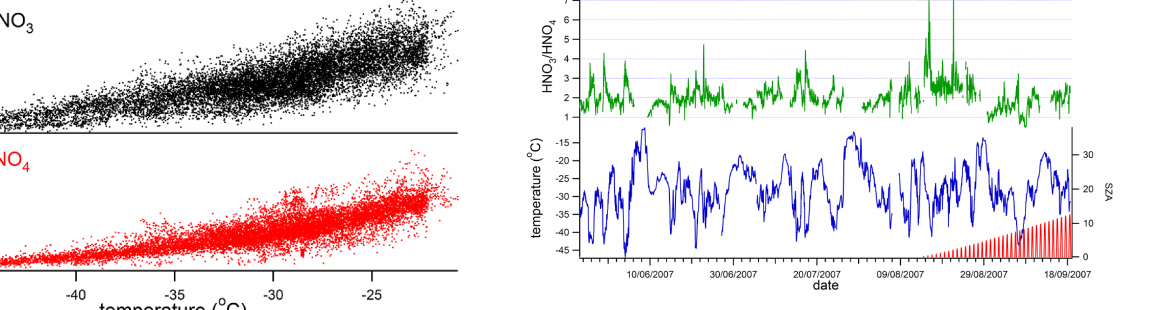
Figure 4. Ratio of HNO 3 : HO 2 NO 2 (hourly average data) for the May to September measurement period. Also shown, for reference, are ambient temperature and solar zenith